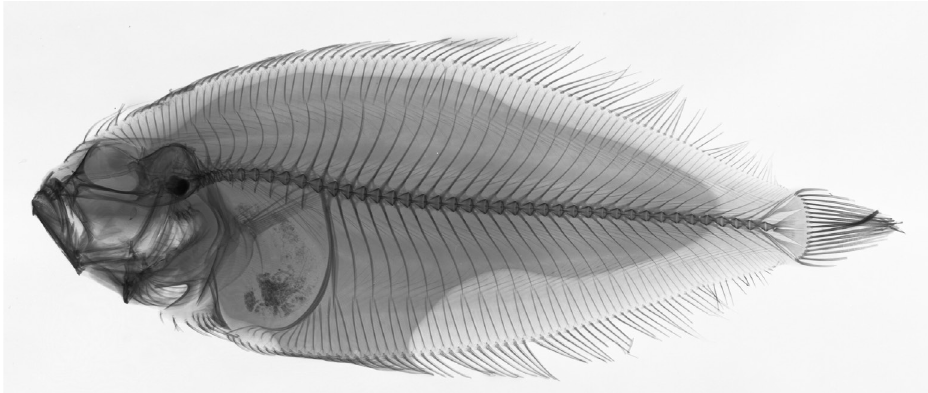
Fig. 2. – Arnoglossus blachei Stauch, 1965, BMNH 1930.5.6.36, one male, 73.7 mm SL, lectotype of A. blachei , 96.6 mm SL, Gabon, 27.2 km west of Cap Lopez. X-ray taken by J. Maclaine.